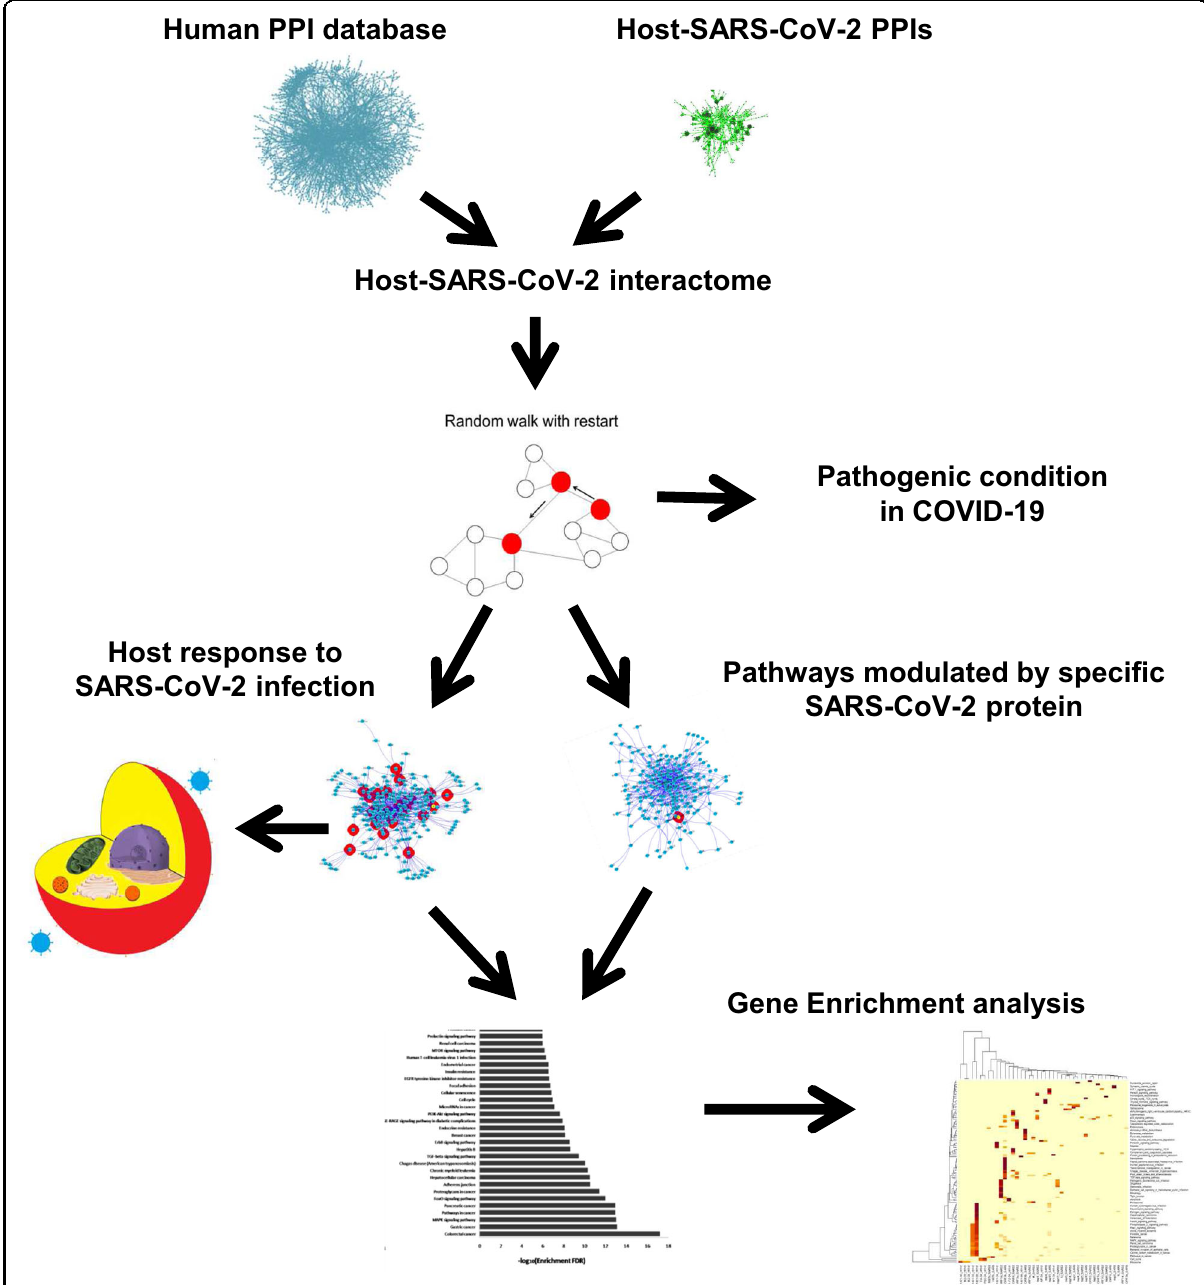
Fig. 1 Work fl ow to describe SARS-CoV-2 host interactome analysis based on PPI data. Human-human PPI database has been merged with Host-SARS-CoV-2 PPIs databases and then an explorative algorithm (Random Walk with Restart) was applied in order to identify host response to SARS-CoV-2 infection, pathways modulations induced by speci fi c SARS-CoV-2 protein and link with pathogenic conditions in